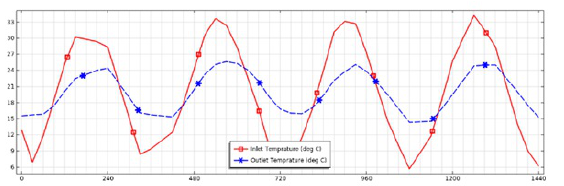
Fig. 12. Time history of Inlet and Outlet temperature for 4